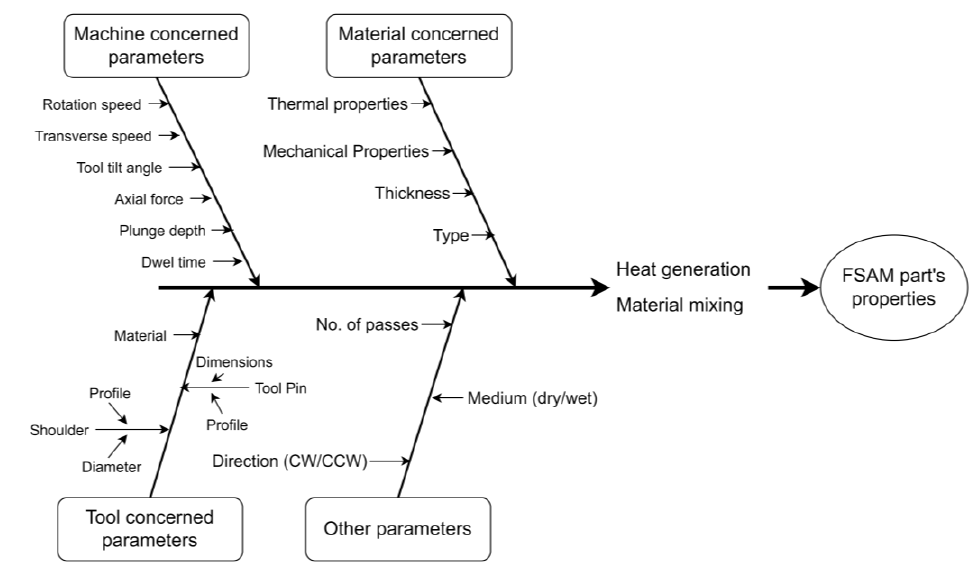
Figure 7. Factors affecting the microstructure and quality of the part produced through